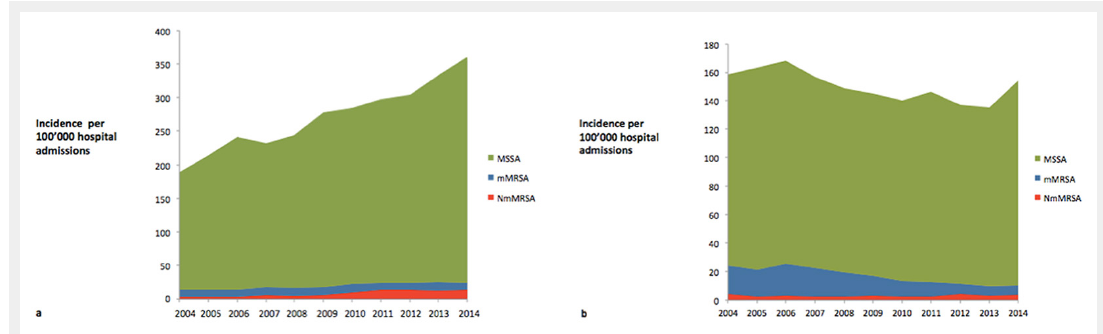
Figure 3 Incidence of methicillin-susceptible S. aureus (MSSA), non-multidrug resistant methicillin-resistant S. aureus (NmMRSA) and multidrug resistant methicillin-resistant S. aureus (mMRSA) per 100000 hospital admissions ( a ) in invasive isolates (excluding bacteraemic isolates) and ( b ) in